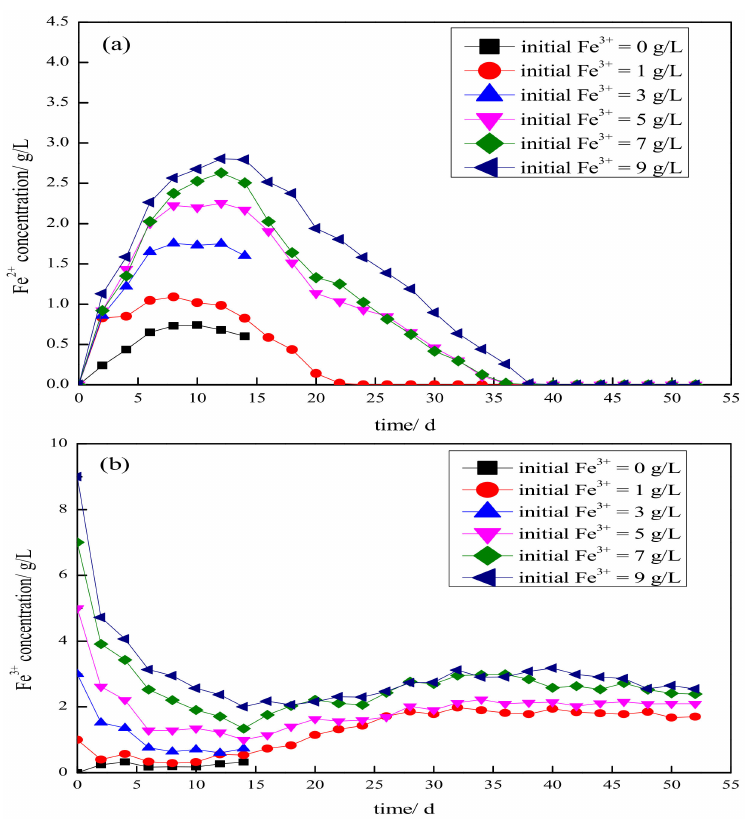
Figure 3. Changes in Fe 2 + ( a ) and Fe 3 + ( b ) in solutions with time.